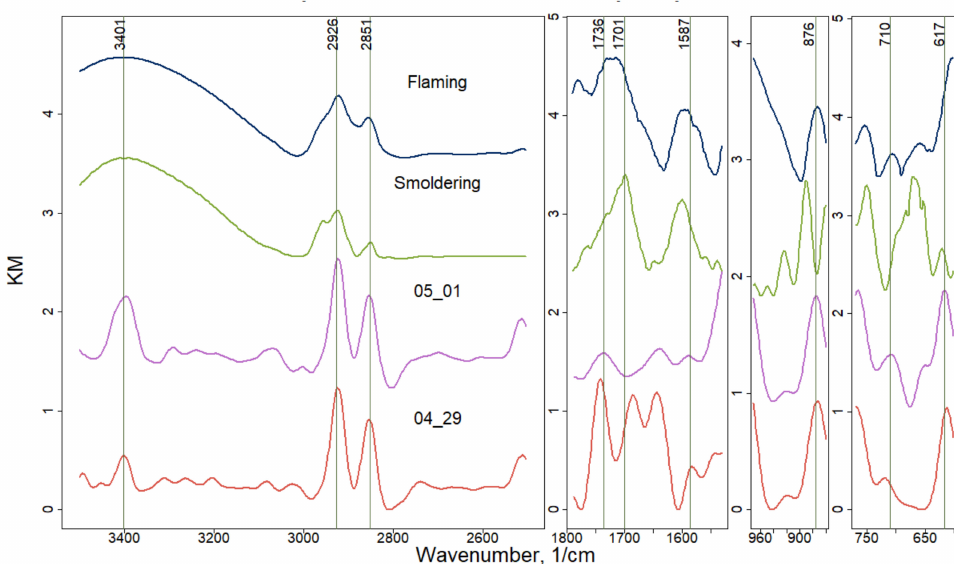
Figure 6. FTIR spectra for 05.01 and 04.29 from the BB-a ff ected period. Spectra of the Moscow regional biomass represented by spruce flaming and mixture smoldering